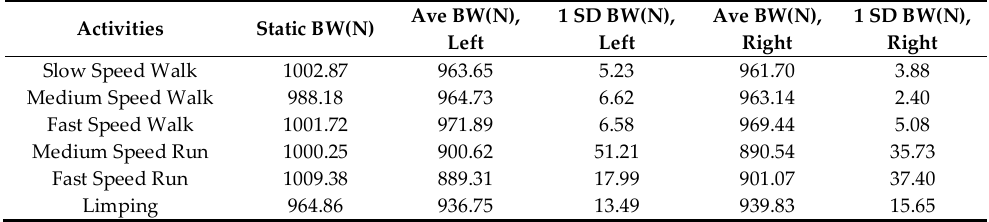
Table 2. Mean ± Standard Deviation of bodyweights calculated for both left and right steps within an